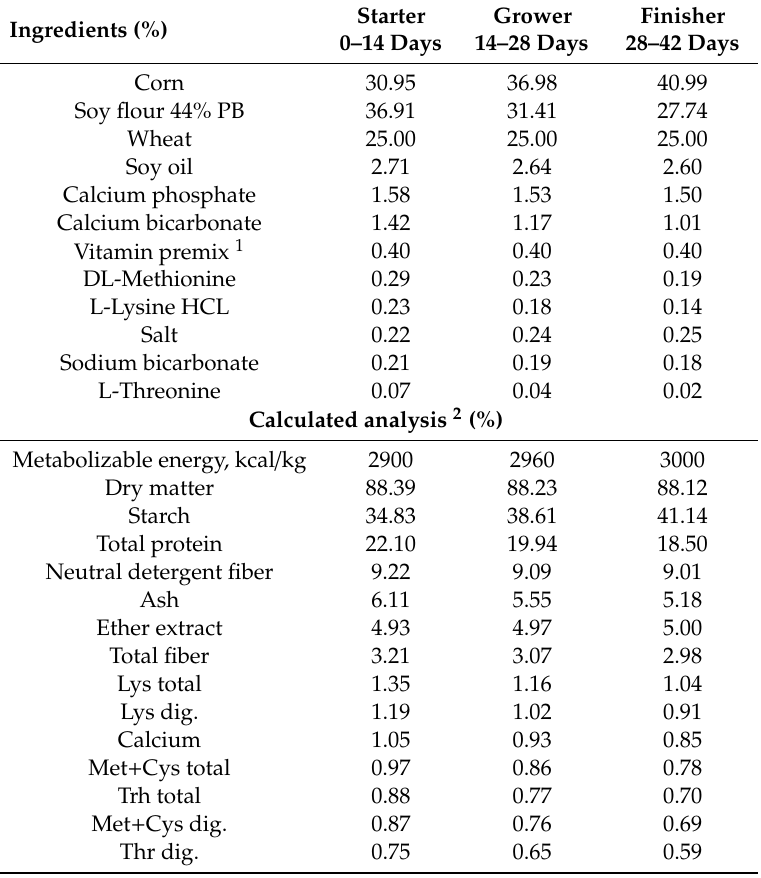
Table 1. Composition of basal